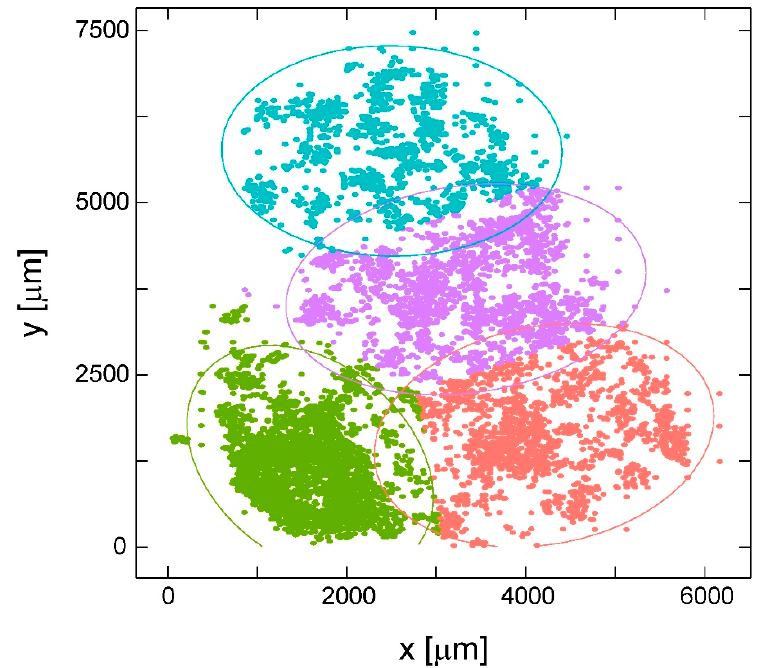
Figure 5. Result of K-means clustering of SH-SY5Y cells grown on TiN nanocolumnar substrates after 3 days. Each data point represents a single cell. The different colors denote cluster 1 (red), cluster 2 (green), cluster 3 (blue), and cluster 4 (purple). The cell distribution corresponds to the autocorrelation function marked with * in Figure 4. Note that the graph does not represent the entire substrate area of 0.22 cm², but only the area covered by cells.